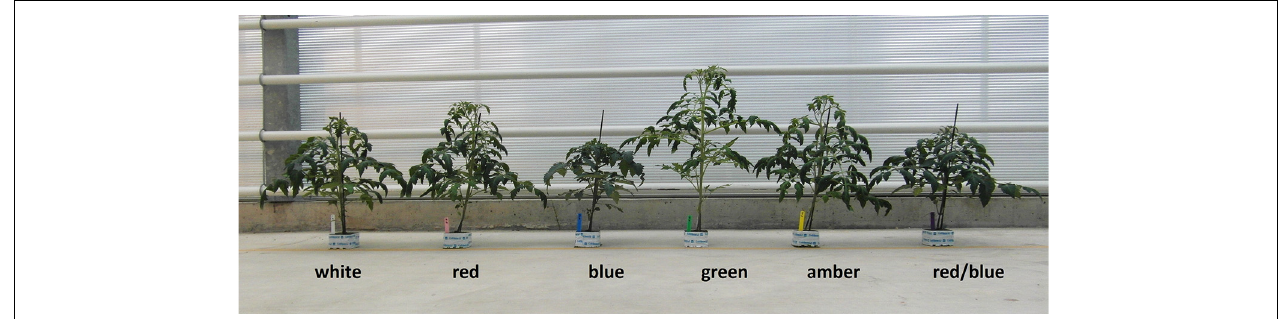
FIGURE 1 | Effect of spectral composition of the light on plant morphology of tomato plants grown under white, red, blue, green, amber and red/blue LED light during 21 days.